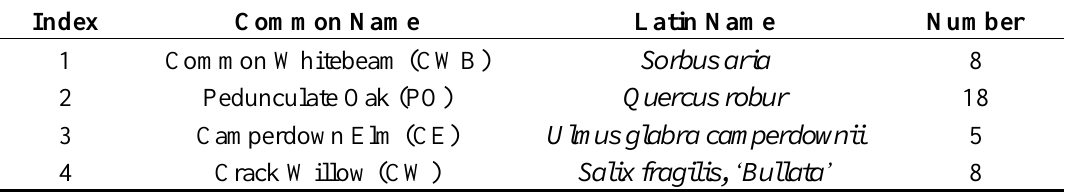
Table 1. The tree species in this study and the numbers of trees per